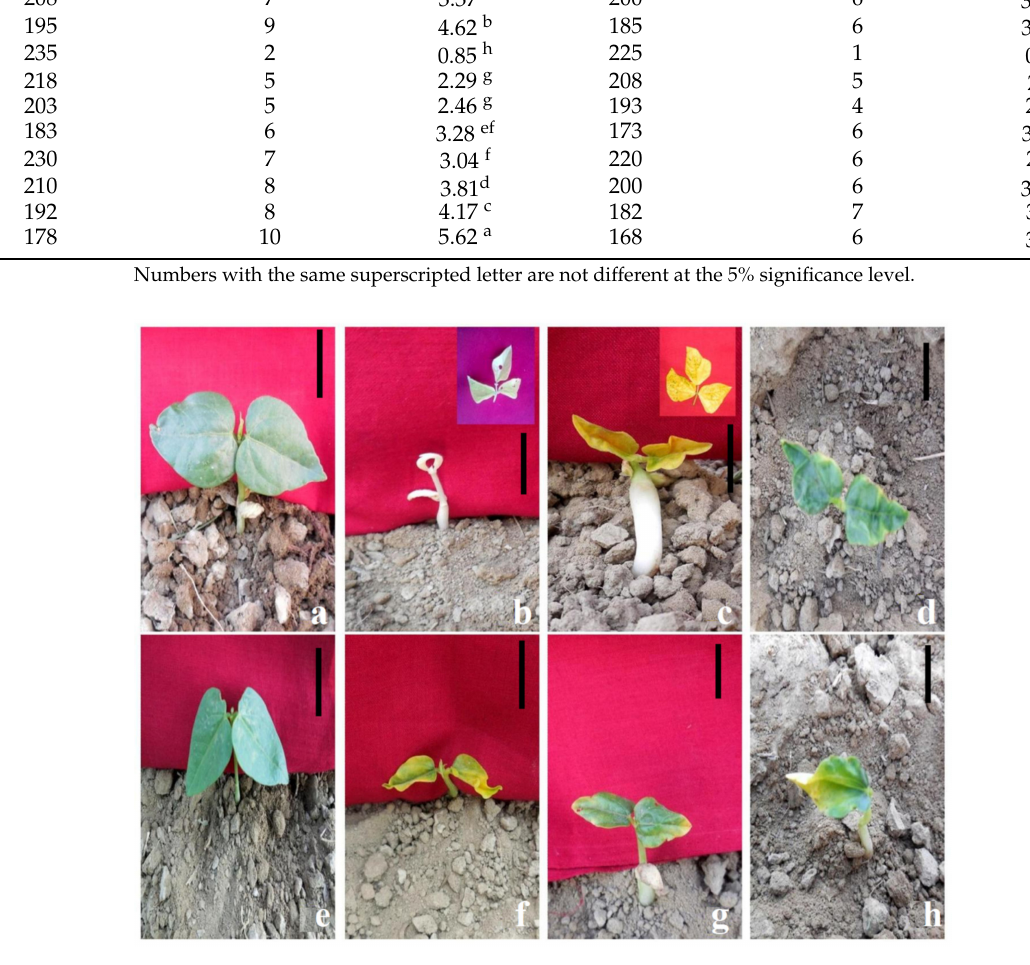
Figure 5. Representative photographs of γ rays and SA-induced chlorophyll mutants. ( a ). Control seedling of var. Gomati VU-89. ( b ) Albina , ( c ) Xantha , ( d ) Tigrina , ( e ) control seedling of var. Pusa-578, ( f ) Chlorina , ( g ) Xanthaviridis , and ( h ) Viridis . Scale Bar = 2